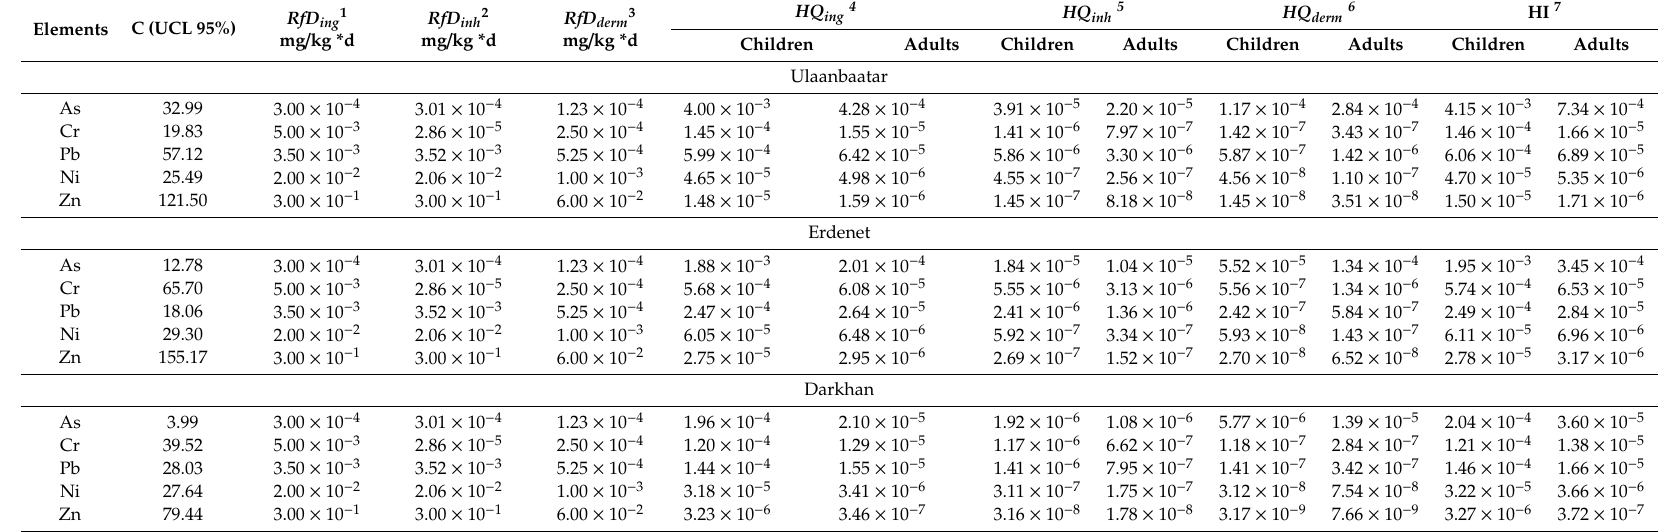
Table 7. HQs and HIs from heavy metals that given with their concentration and reference dose in the studied cities’